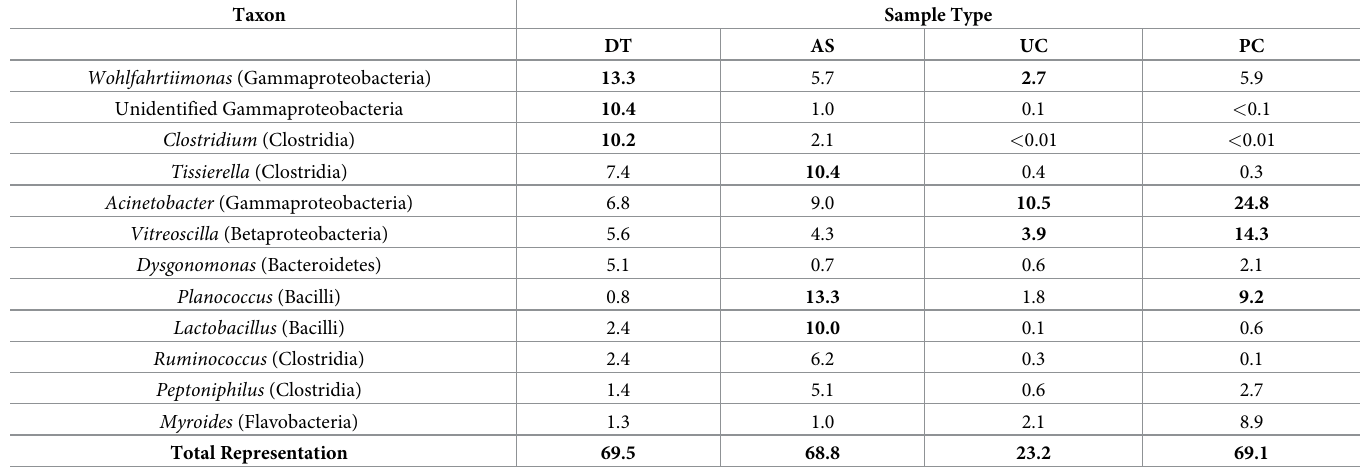
Table 1. Percentage of prevalent bacterial taxa found across sample types. Taxonomic assignments of the most common bacterial genera found in each sample type, with their class-level designation given in parentheses. A relative abundance threshold of > 10% of all sequences was used here for taxa considered to be ‘prevalent’; how- ever, values lower than 10% also appear for comparative purposes. Bolded percentages represent the three most abundant bacterial groups within a given sample type, and the bottom row shows the total percentage of all sequences within a given sample type. Acronyms are as follows: DT–Adult digestive tract, AS–Anal secretions, UC–Unpre- pared carcasses, PC–Prepared